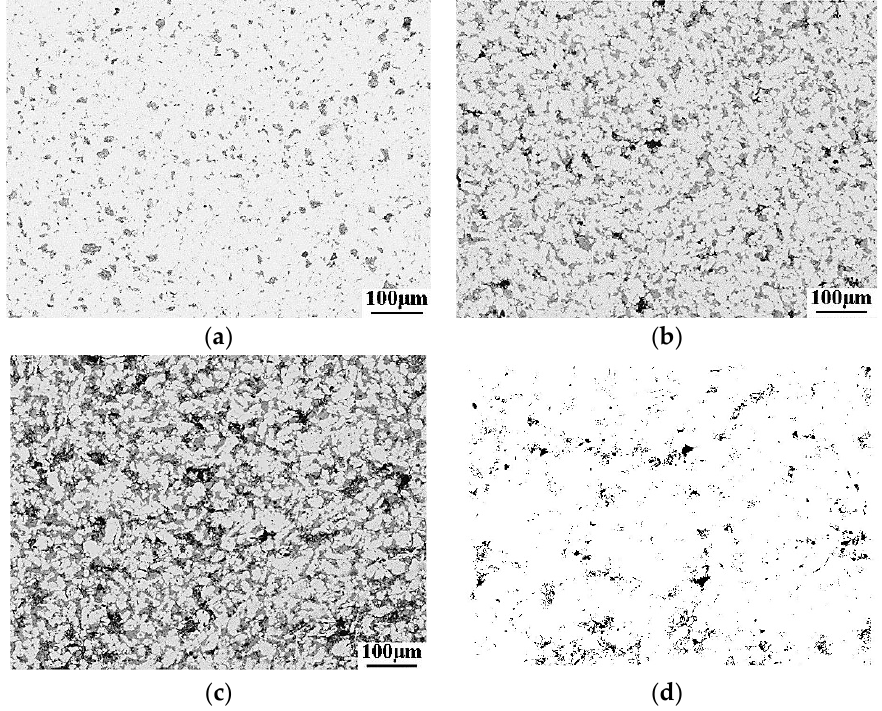
Figure 2. Typical morphology of Ti 3 AlC 2 /Cu composites with different content: ( a ) the volume fraction of Ti 3 AlC 2 is 10 vol.%; ( b ) 30 vol.% Ti 3 AlC 2 ; ( c ) 50 vol.% Ti 3 AlC 2 , ( d ) network fractions of threshold concentration.